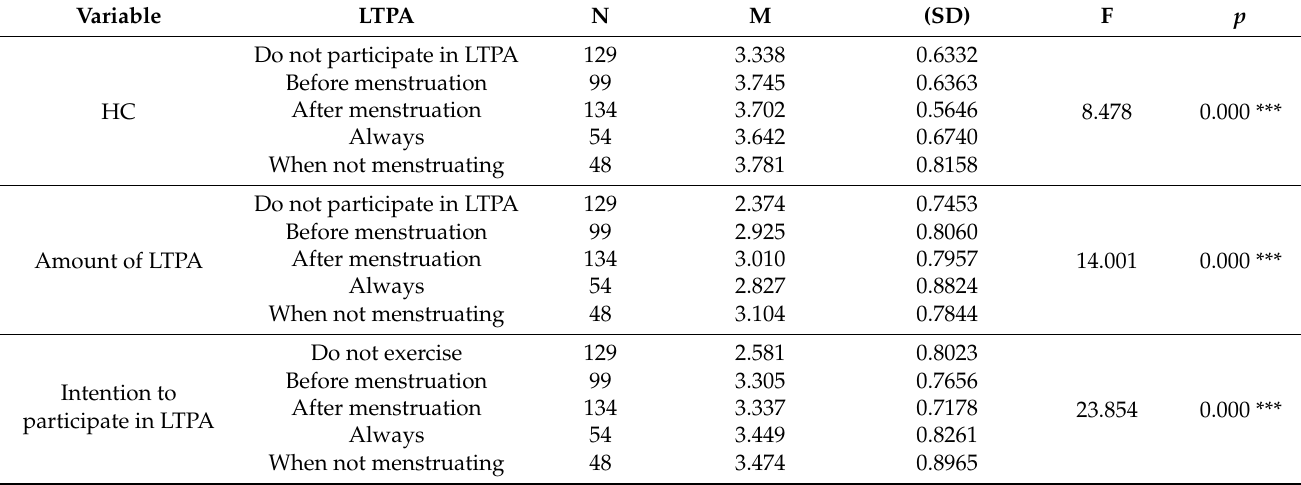
Table 6. ANOVA among HC, amount of LTPA, and intention to participate in LTPA. Variable